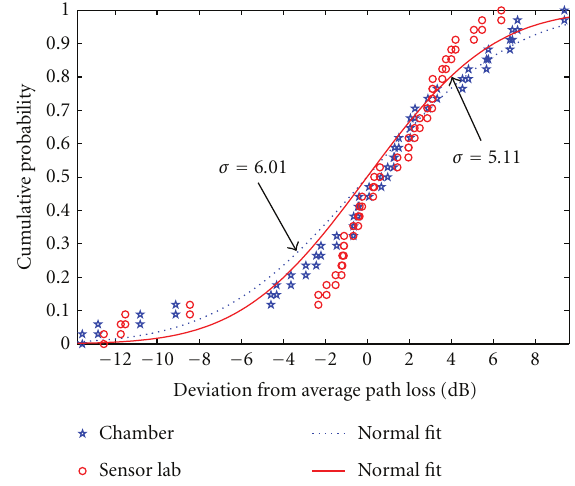
Figure 10: Deviation of the measurements from the average path loss fitted to normal distribution for both chamber and indoor measurement